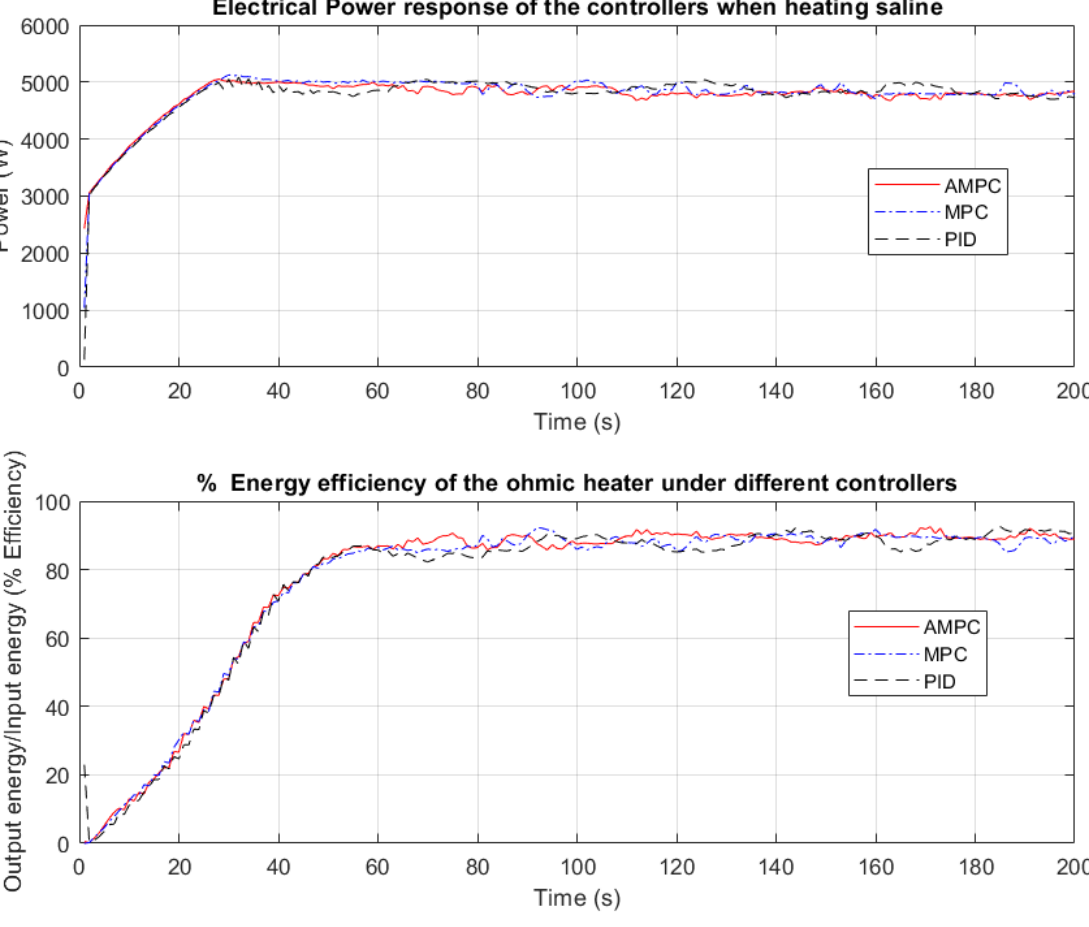
Figure 5. Electrical power and energy efficiency of the ohmic heater while heating saline.